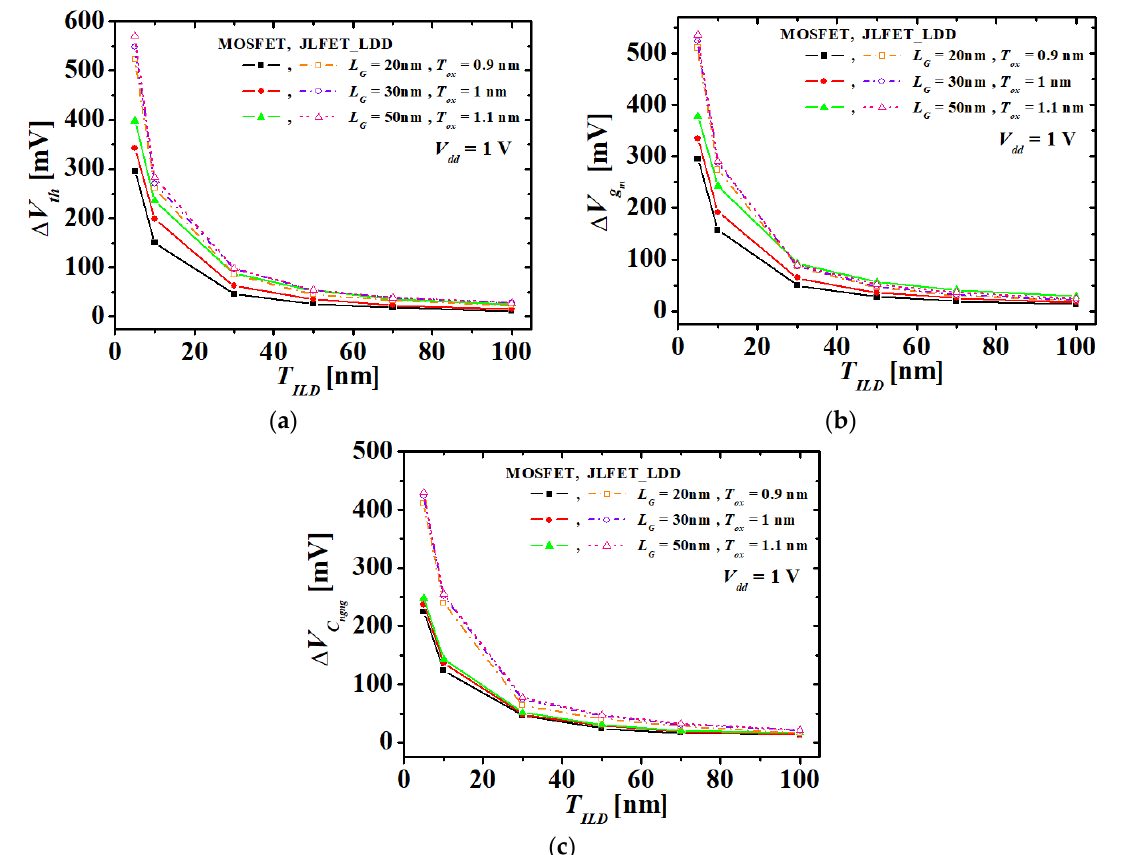
Figure 4. ( a ) Δ V th of the top transistor, ( b ) Δ V gm of the top transistor, and ( c ) Δ V Cngng of the top transistor at between V pgs = 0 and 1 V in the M3INV cell. Here, V nds = 1 V, and frequency f = 1MHz for calculating g m and C ngng .